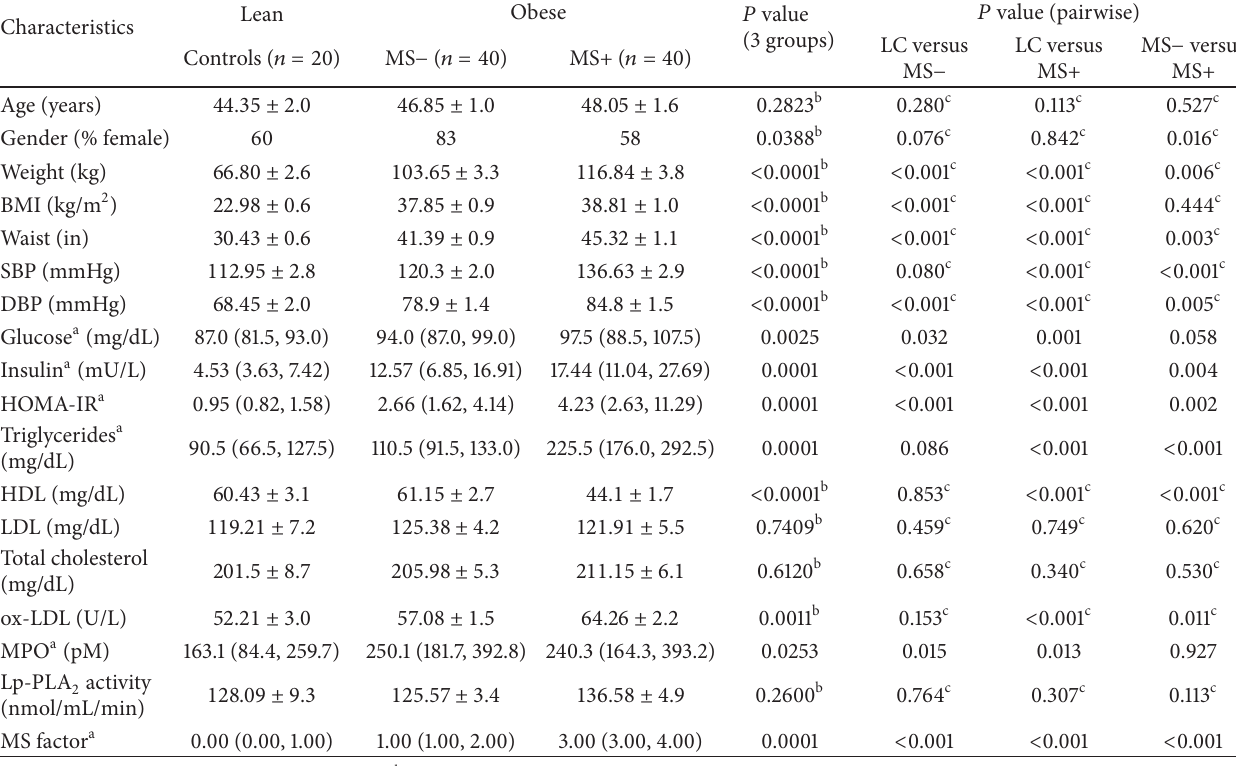
Table 1: Baseline characteristics among 20 lean controls and 80 obese adults with and without the metabolic syndrome (values are expressed as a median (IQR), all others as means ± SE).